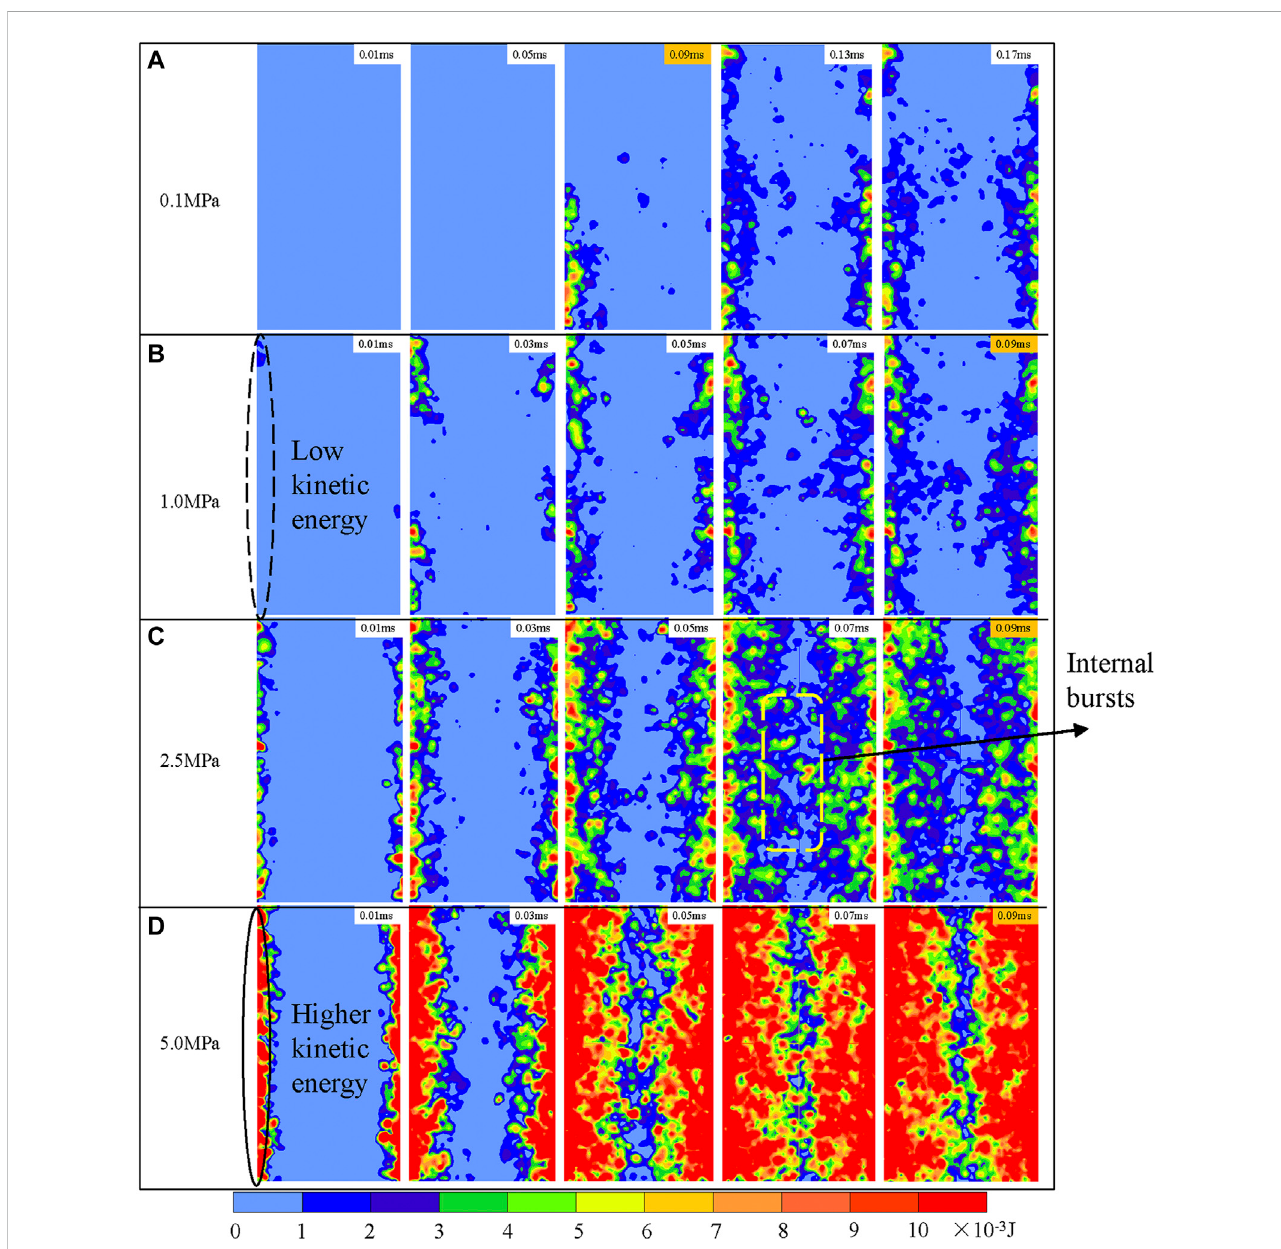
FIGURE 10 Distribution of kinetic energy under different pre-con fi ning pressures of (A) .1 MPa; (B) 1 MPa; (C) 2.5 MPa and (D) 5 MPa for different points in time.